Question: What direction does the quantity move in — increasing or decreasing?
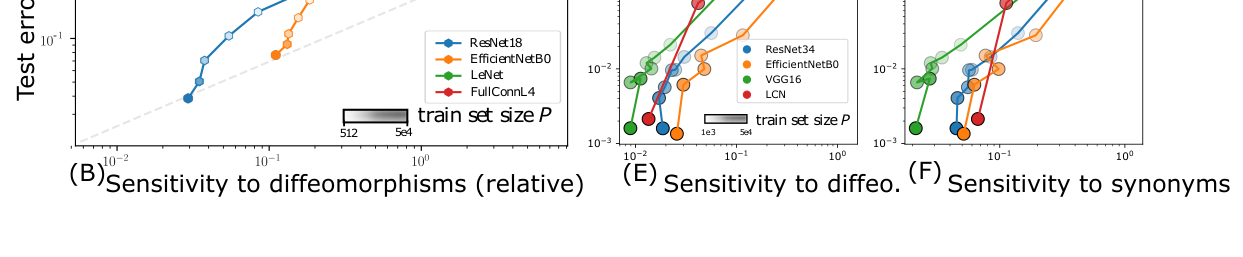
Answer: increasing